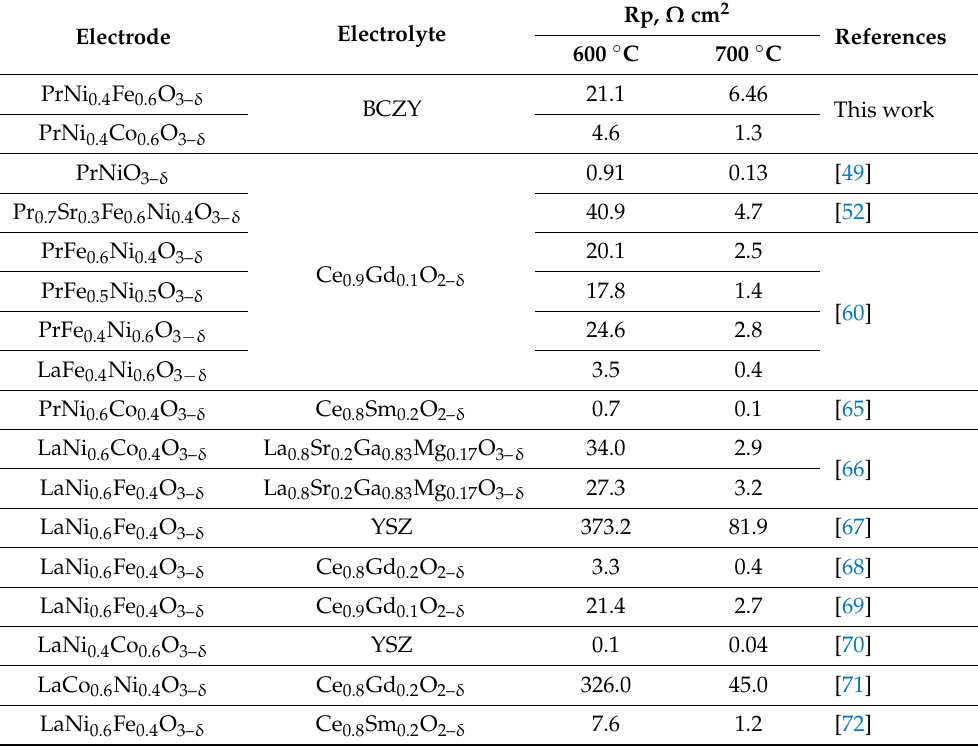
Table 3. Polarization resistance values of symmetrical cells with PrNiO 3 -based